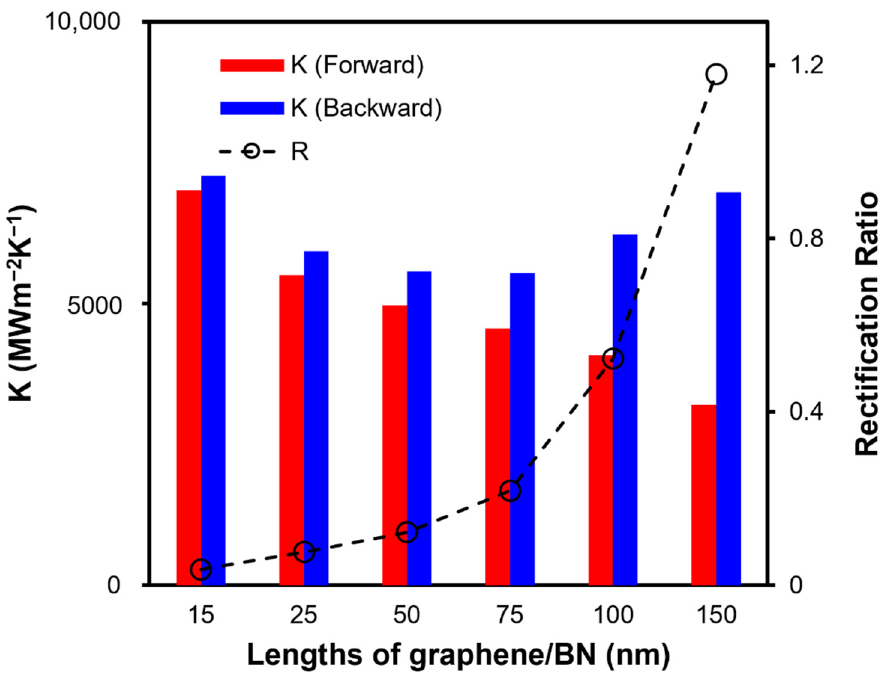
Figure 4. Forward and backward interfacial thermal conductance of graphene/BN with lengths of 15, 25, 50, 75, 100, 150 nm and the corresponding rectification ratio.